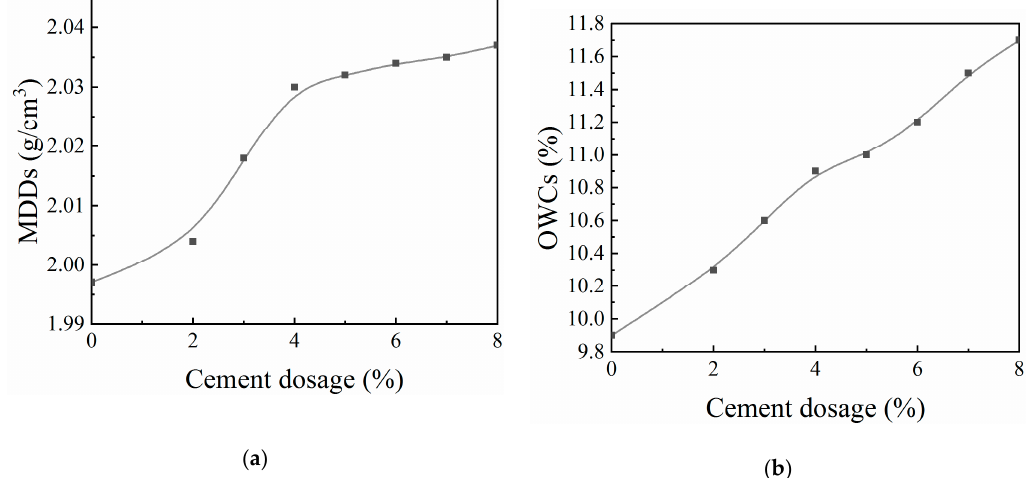
Figure 3. Maximum dry densities (MDDs) and optimal water contents (OWCs) of the cement-modified loess (CML) fabricated using the vertical vibration compaction method (VVCM): ( a ) relationship between cement dosage and MDDs for cement-improved loess; and ( b ) relationship between cement dosage and OWCs for cement-improved loess.